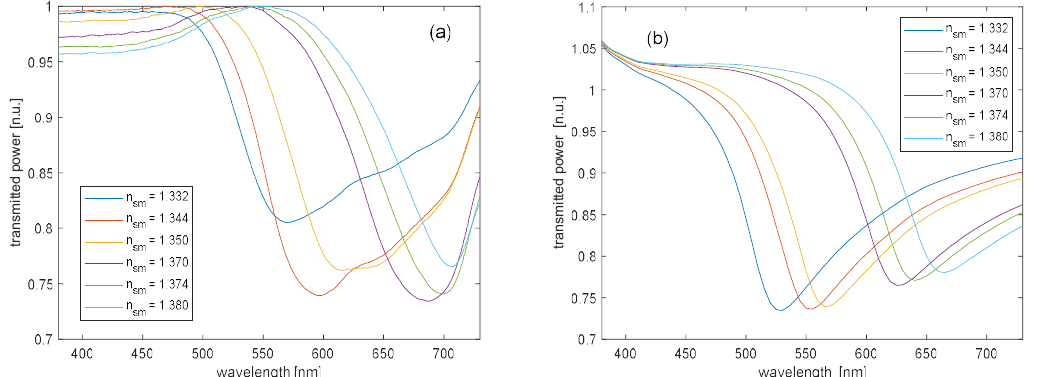
Figure 3. SPR spectra of the silver-coated sensor, after normalization to the transmission spectrum in air: ( a ) Experimental results; ( b ) numerical results.